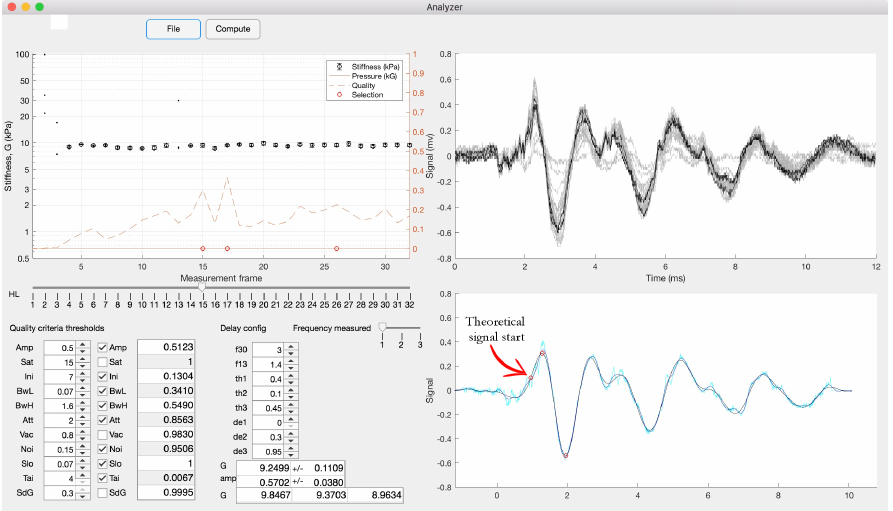
Figure 4. Example of an output of the analyzer software used to analyze the signals obtained from the TWE technique. The upper left sub-figure shows the stiffness obtained at each measurement frame. The lower-right sub-figure shows the theoretical signal